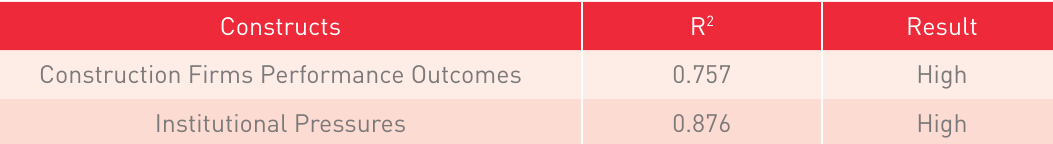
R-Square of the Endogenous Latent Variables